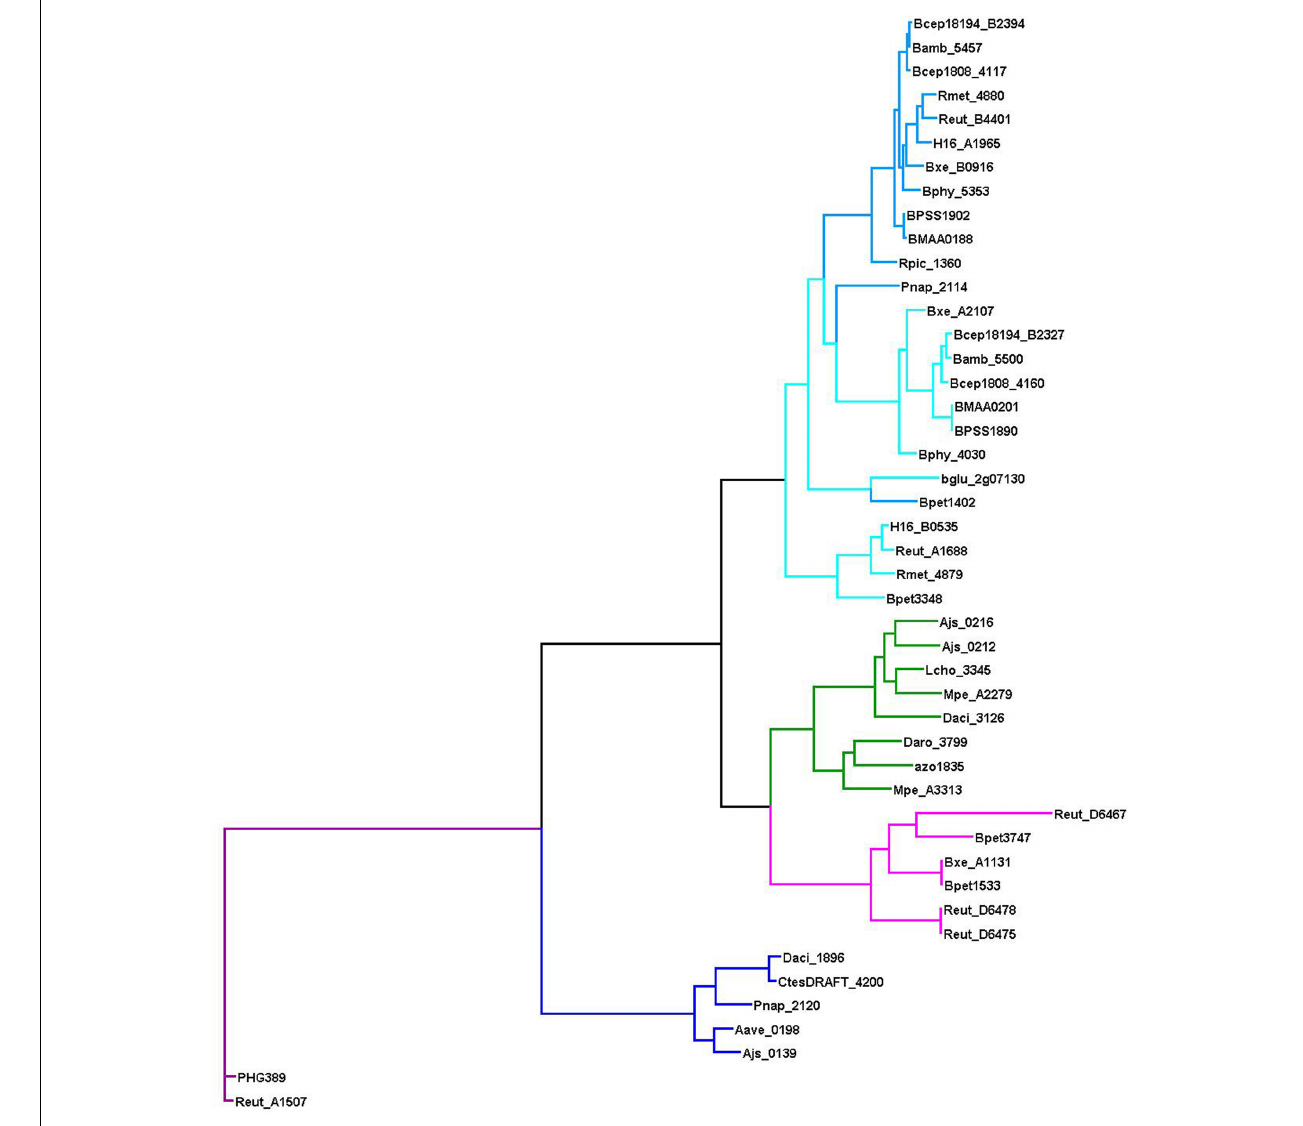
FIGURE 8 | Phylogenetic tree of the LysR-family regulators of the aromatic metabolism. The color code is consistent with that in Figure 1 : AphT – green, CatR – light blue, CatM/BenM – blue, CatR ∗ – dark blue, ClcR and TfdR(S) – magenta, MmlR –